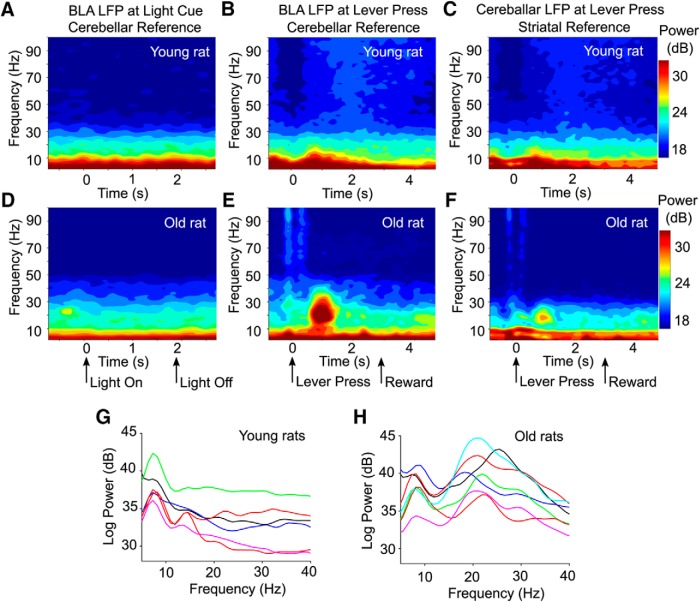
Significant β-band oscillation (15–30 Hz) power increase in old rats after lever presses. A, Normalized spectrogram of an example recording session from a young rat, with 0 being aligned to light cue onset. For this example, the recording electrode was located in BLA and the signal was rereferenced to a cerebellar screw in the skull. The light cue was 2 s in duration (indicated by the arrows below D). B, Normalized spectrogram of the same rat and recording session as in A, with 0 being aligned to the lever press and the signal rereferenced to a cerebellar screw. Reward delivery occurred 3 s after lever press (indicated by the arrows below E). C, Same spectrogram time point as for B. Signal is taken from the cerebellar LFP recording screw which reflects the signal between it and the reference tetrode located in a quiet area in the fiber bundle dorsal to posterior striatum. D, Same as A, for an old rat. E, Same as B, for an old rat, taken from the same rat and session as in D. Note the elevated power in the β range, around 15–30 Hz. F, Same spectrogram time point as E. Signal is taken from the cerebellar LFP recording screw which reflects the signal between it and the reference tetrode located in a quiet area in the fiber bundle dorsal to posterior striatum. Note the attenuated signal in the β-range frequencies (15–30 Hz) near posterior striatum as compared to that of the BLA LFP signal in D. G, Power spectra from all young rats during the first session of the late training phase of the reward discrimination task. Average session spectra taken during the period after a lever press (0.3–2.0 s post-lever press), showing an elevated theta peak, but not β in the young rats (each color represents the power spectra of a different rat). This is with the exception of one young rat showing elevated power around 15 Hz. H, Same as in E, for all aged rats. Figure shows elevated power in the theta and β ranges in all aged rats.